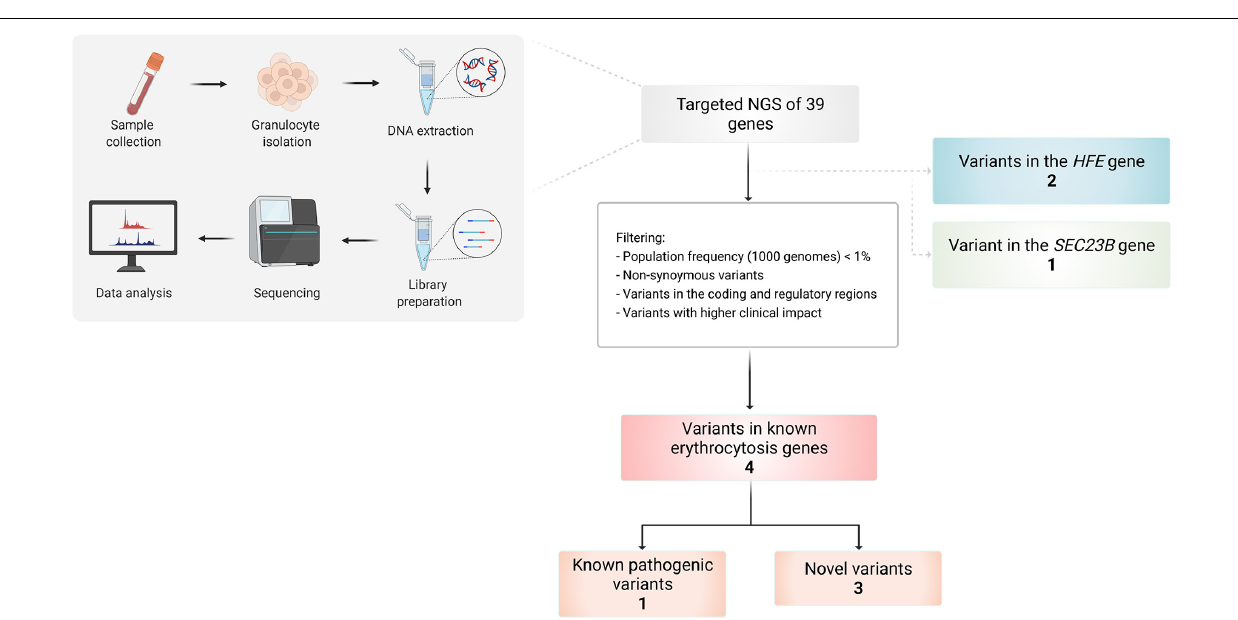
Frontiers in Genetics |